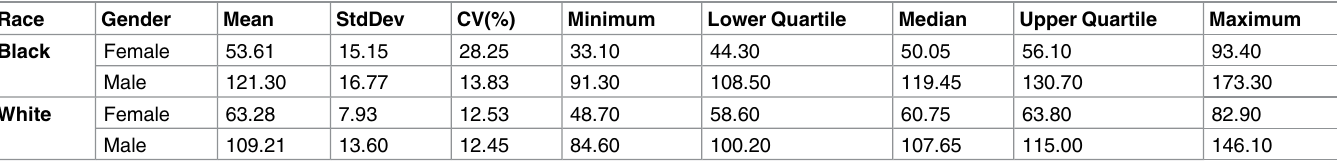
Table 9. Summary statistics for lung cancer incidence rates for Blacks and Whites in the Mid-South by gender, 1999–2012(cases per 100,000).